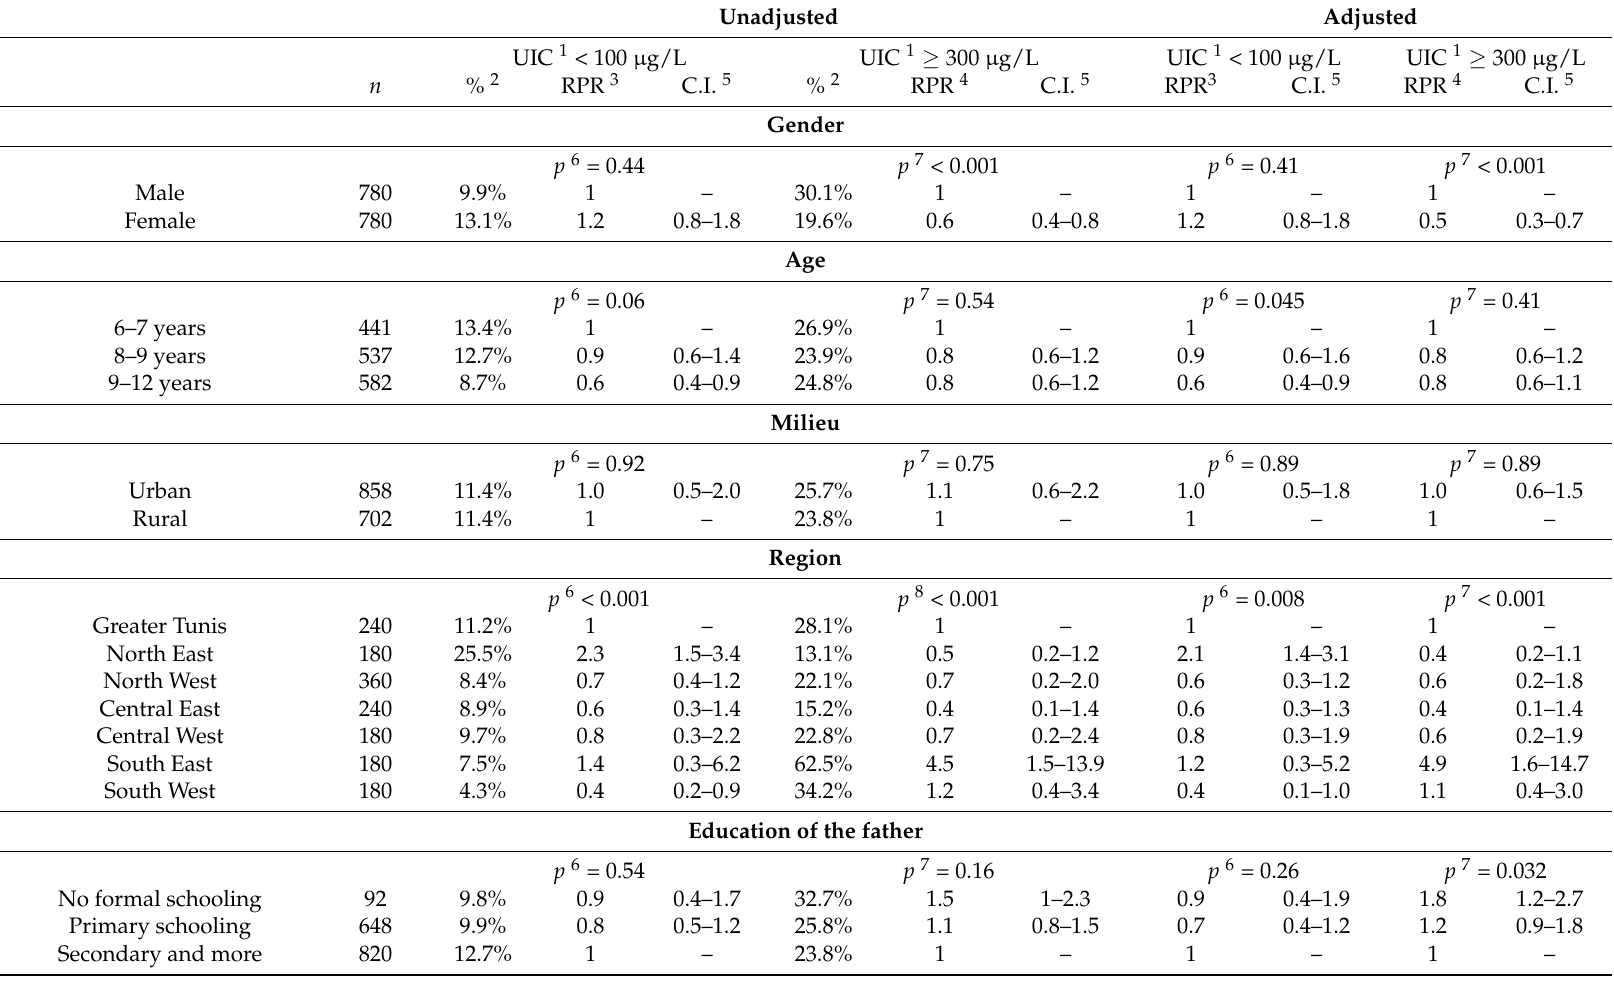
Table 3. Association between urinary iodine concentration and place of residence, socio-demographic factors, anthropometry and salt iodine